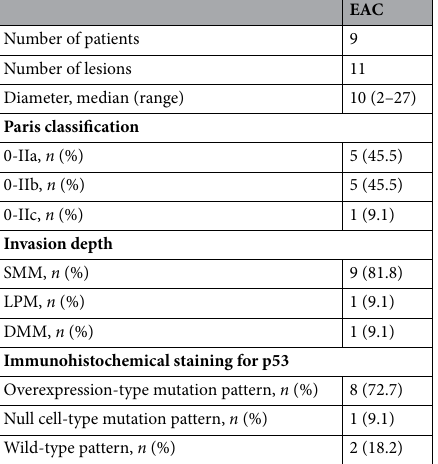
Fig. 4. Among the 11 lesions, the numbers of overexpression-type mutation, null cell-type mutation, and wild- type patterns were eight (78.7%), one (9.1%), and two (18.2%), respectively (Table 2). In addition, three lesions from the same patient (EAC patient 1) were all overexpression-type mutation patterns.